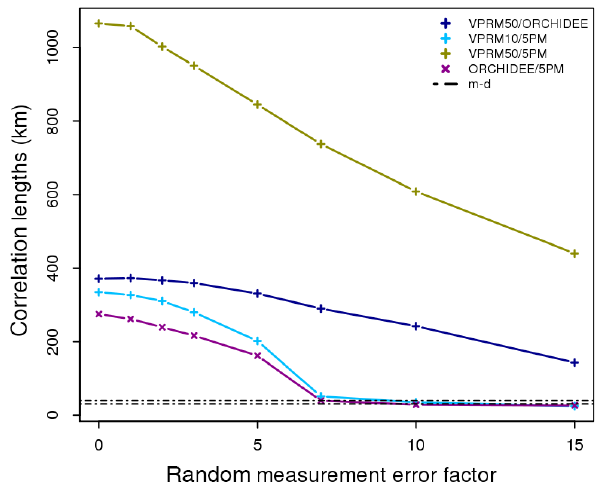
Figure 10. Annual e-folding correlation lengths as a function of the factor used for scaling the random measurement error, for all model–model combinations. The black dot-dash lines reveal the range of the spatial correlation lengths generated from the model– data